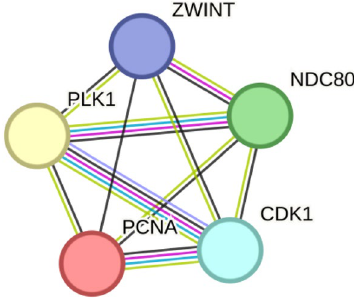
Figure 10. Protein–protein interaction network for hub